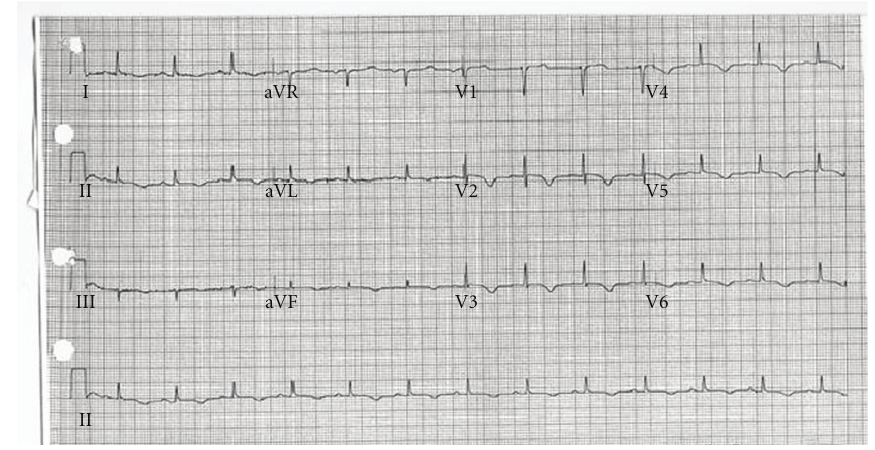
Figure 1: EKG: sinus rhythm and normal axis, significant for deep anterolateral T wave inversions.